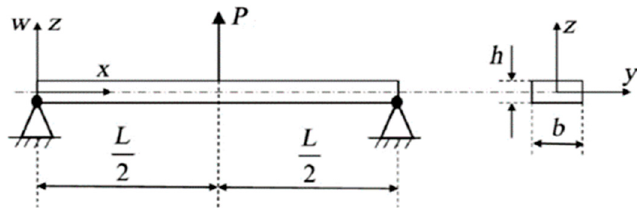
Figure 1. A hinged-hinged nano-beam.